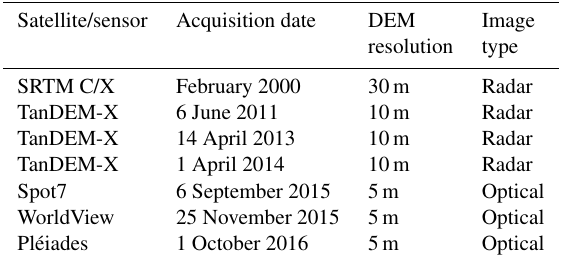
Table 1. Different DEMs used in this study produced from satellite